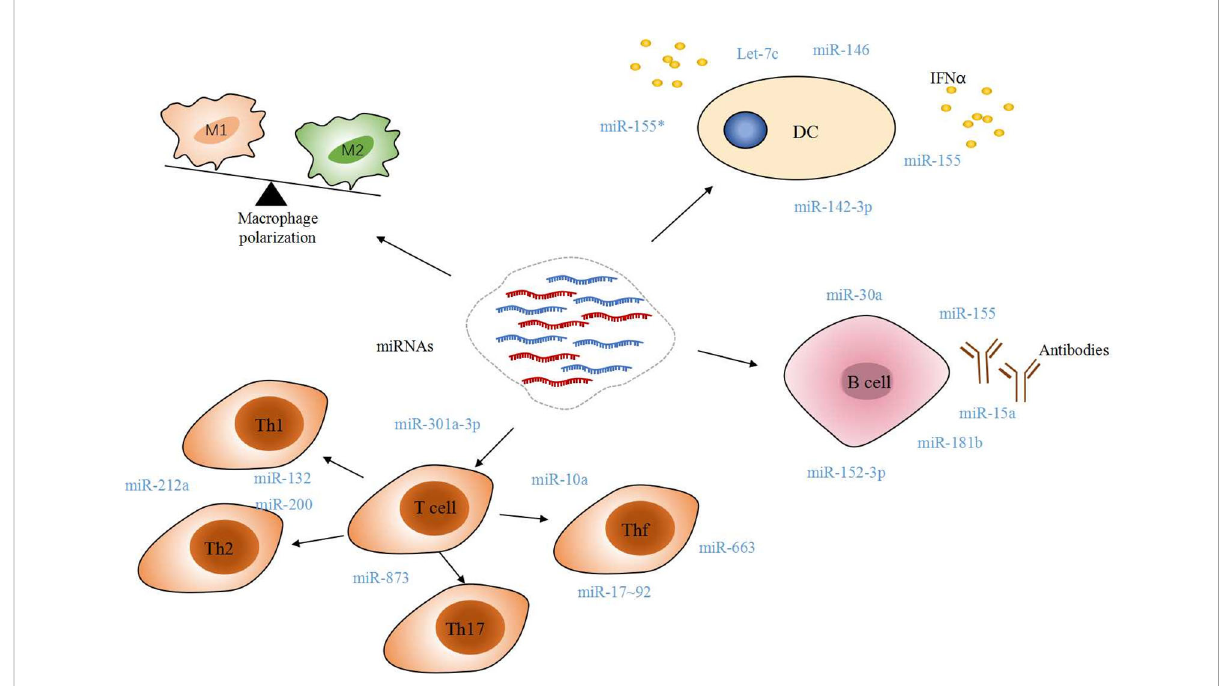
FIGURE 2 Immune modulatory miRNAs involved in SLE. Dysregulated macrophage polarization and T cell differentiation partially blame on miRNAs. A mass of miRNAs would trigger IFN a released in DC, B-cell self-reactivity and autoantibody production. All of these manners contribute to the pathogenesis of SLE, directly or